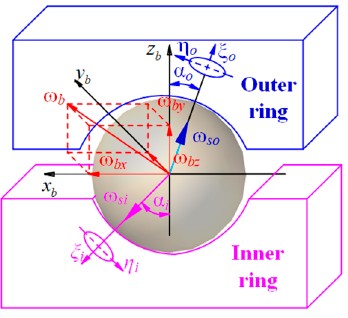
Figure 6. The motion of the ball. The spin-roll ratio of the ball can be written as: